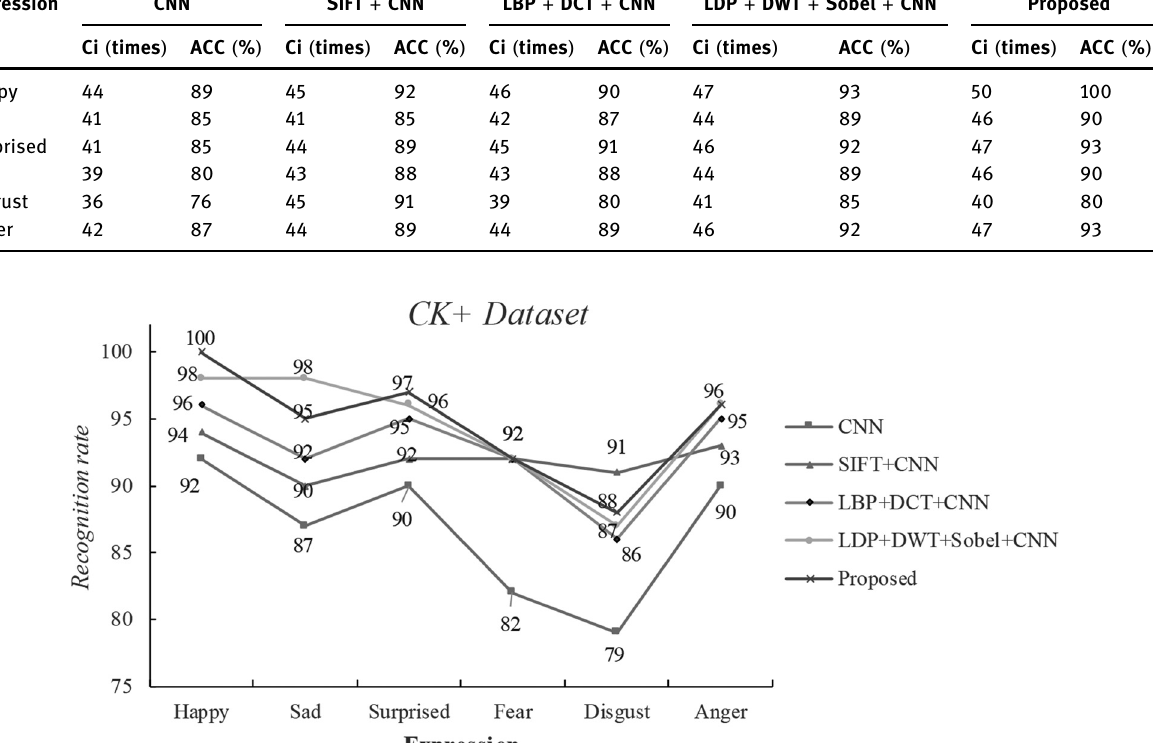
Table 2: Result comparison of di ff erent algorithms in the FER2013 dataset, where Ci means correct identi fi cation and ACC means recog - nition rate Expression